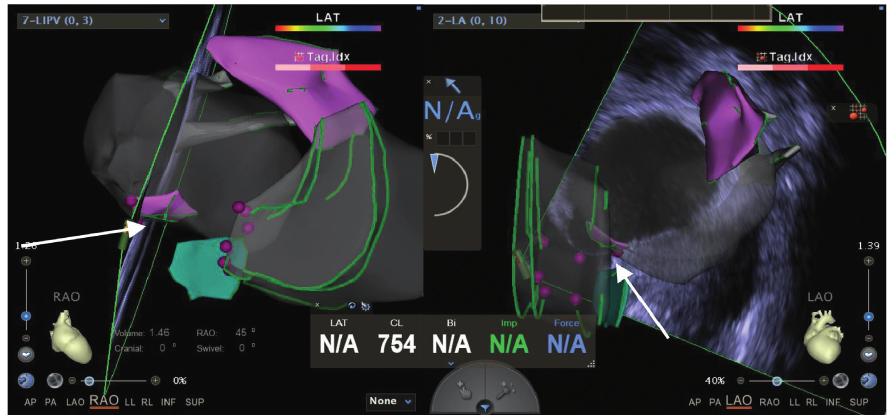
Figure 4: Establishing the left atrium model with intracardiac echocardiography (ICE) and using electroanatomical mapping systems (EAMs) and ICE to confirm the location of the foramen ovale (shown by the